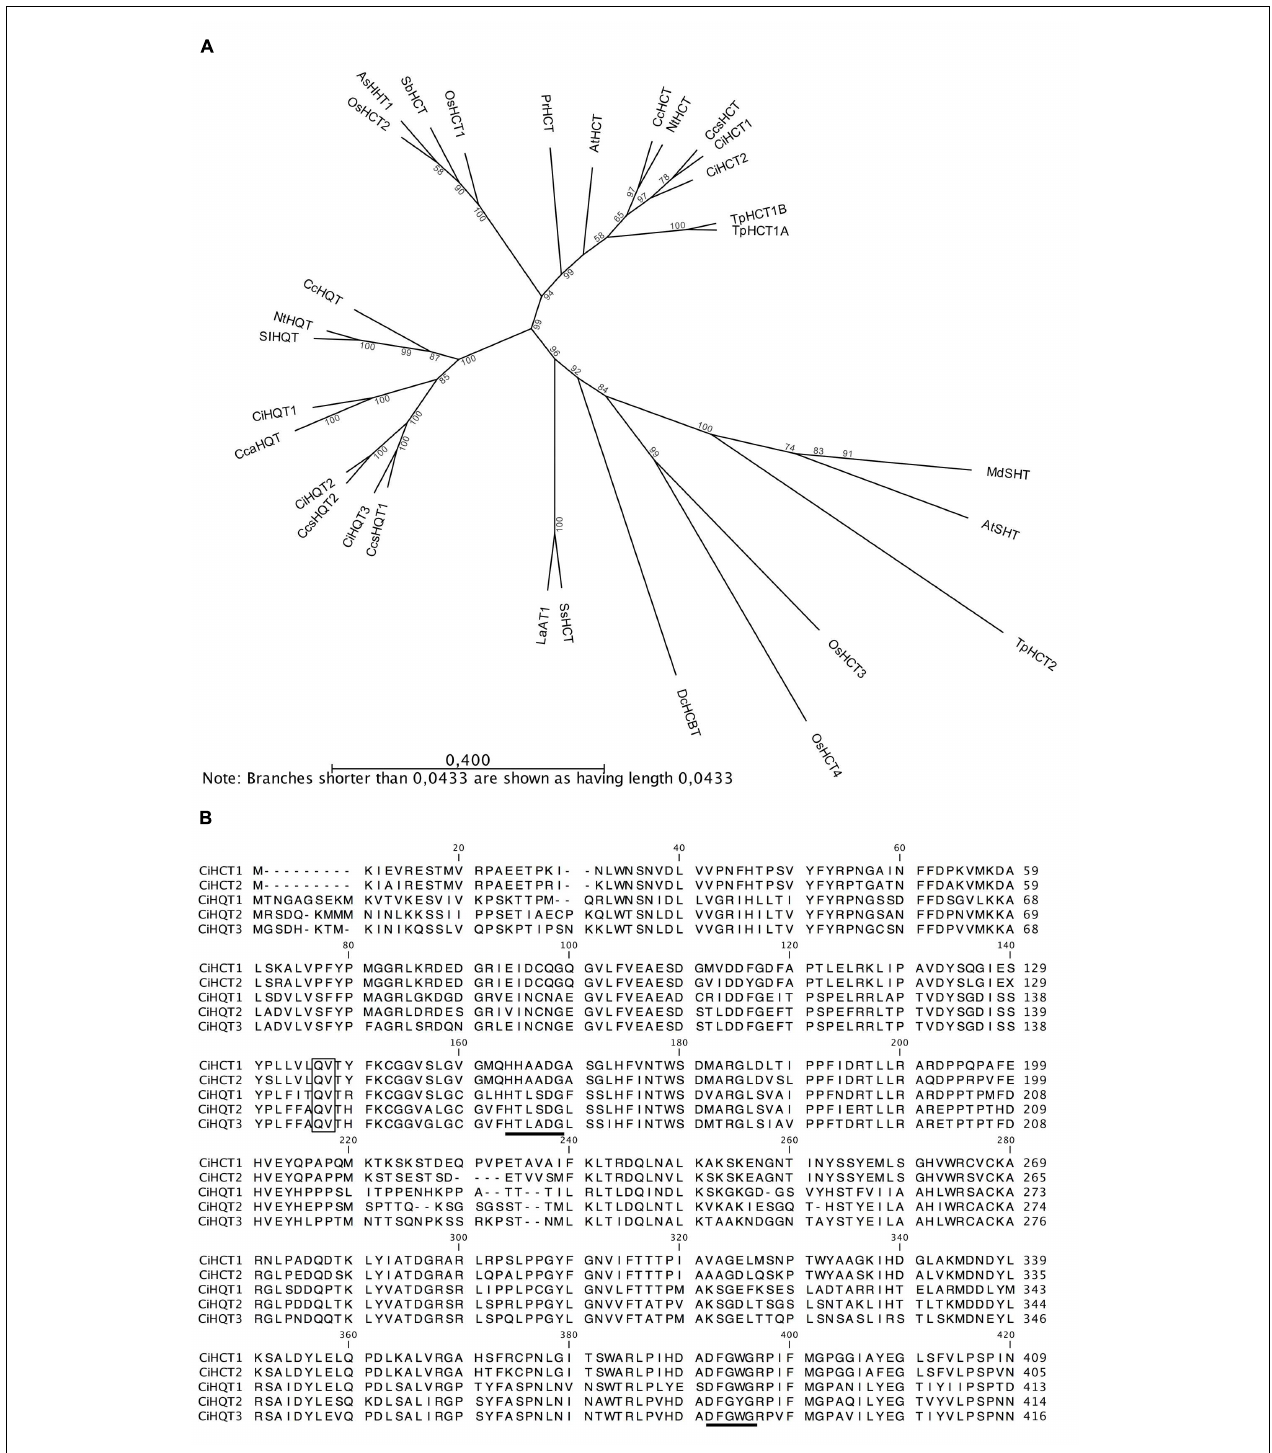
FIGURE 5 | Phylogenetic analysis and sequence comparison of the five members of the BAHD family identified in this study. (A) Phylogenetic tree based on the amino acid sequences of HCTs and HQTs from chicory and biochemically characterized members of BAHD family members. Only the clade Vb is represented. The phenogram was generated by the neighbor-joining method following alignment by the MUSCLE algorithm (with default parameters) using CLC Sequence Viewer 7 software (bootstrap method, 500 replications). The length of the line indicates the relative distance between nodes thanks to the scale bar provided. (B) Amino acid sequence comparison of chicory HCTs and HQTs. Black bars indicate the conserved BAHD acyltransferase domains (HXXXDG and DFGWG). The intron